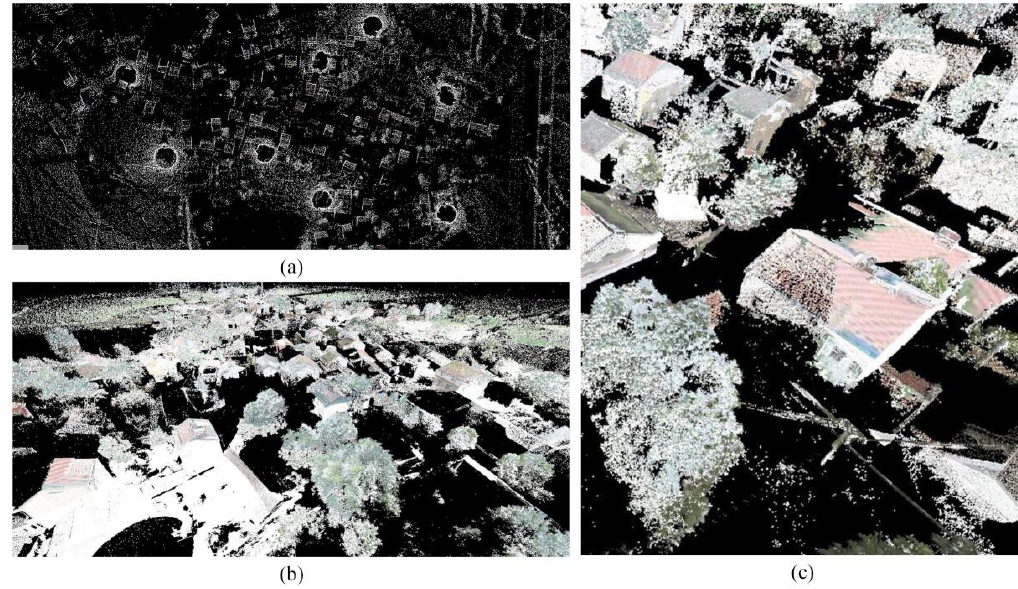
Figure 4. ( a ) 3D point cloud of the Ma’anshan Village collected and integrated from eight stations; ( b ) a close-up view of colored points; ( c ) building samples occluded by dense vegetation.